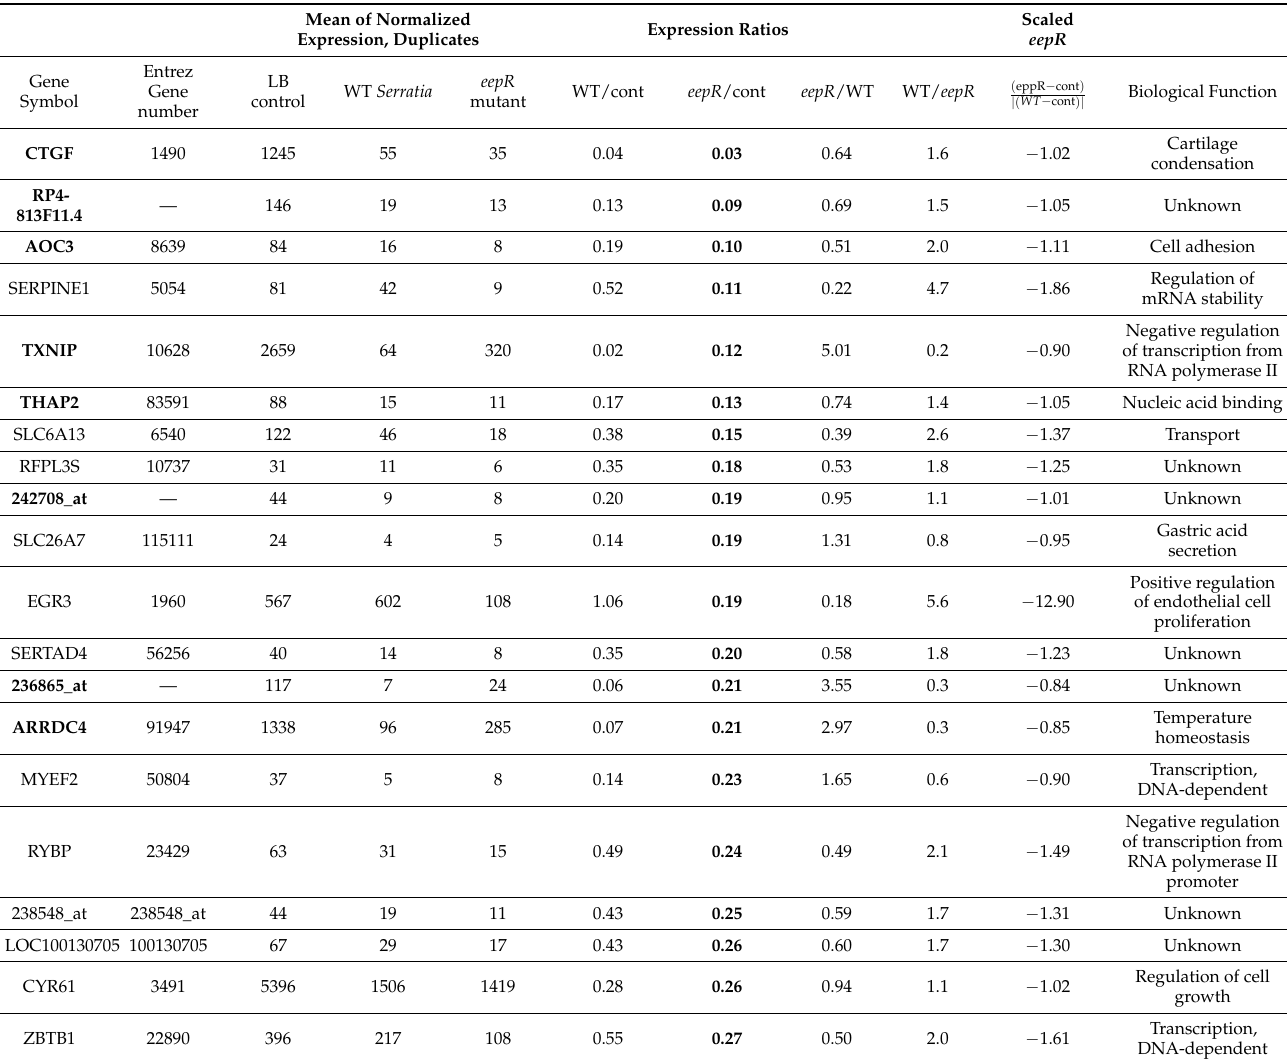
Table 4. Twenty-five genes with the greatest expression decrease in cells treated with eepR vs. mock secretomes. Mean of Normalized Expression,